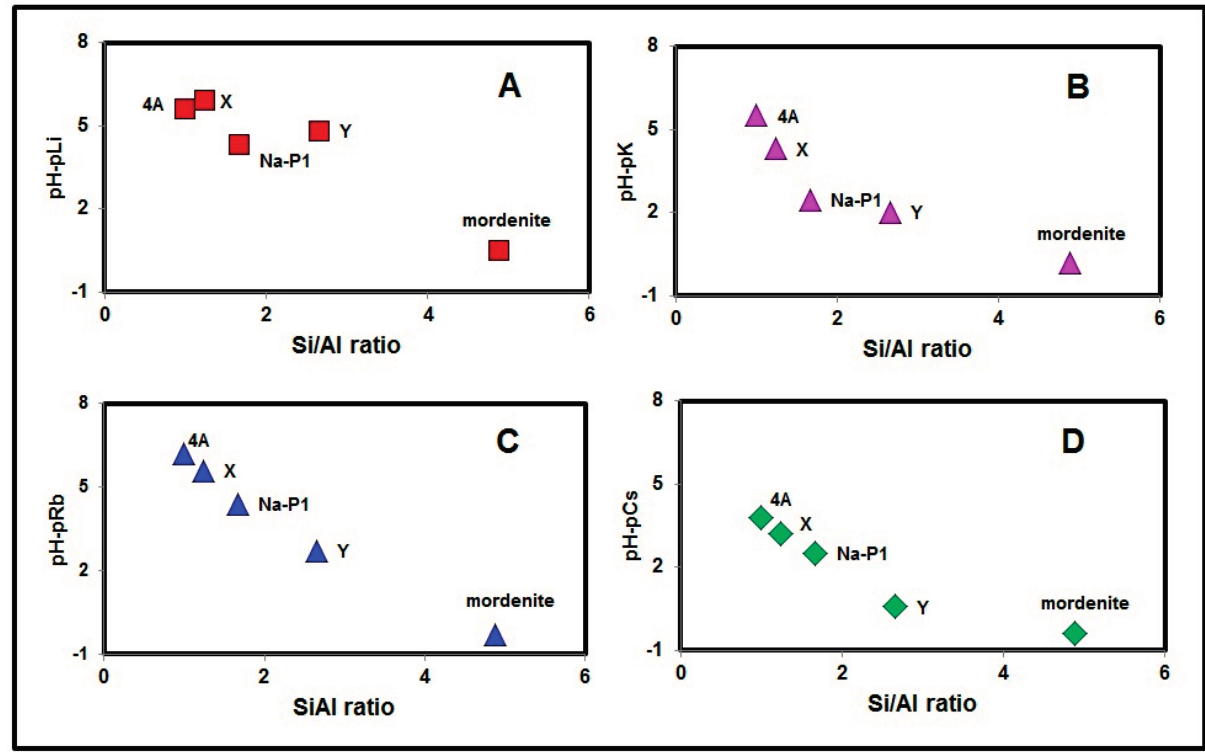
Figure 3. Correlation between (pH-pM) 90 and Si/Al ratio of zeolites. ( A ) Li-zeolites, ( B ) K-zeolites, ( C ) Rb-zeolites, ( D ) Cs-zeolites.